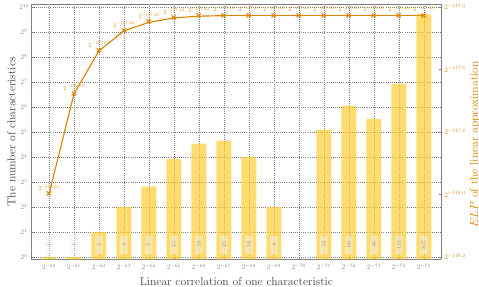
Figure 10: Distribution of characteristics belonging to the 19-round linear